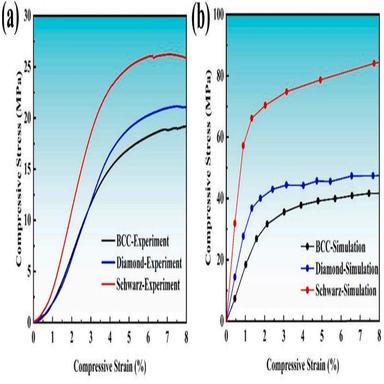
Compressive stress-strain curves of (a) actual testing, and (b) FEM simulation.